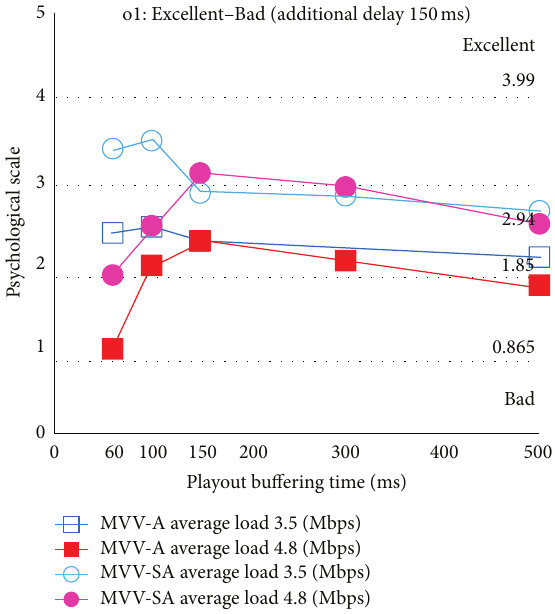
Figure 10: Overall satisfaction: additional delay 150